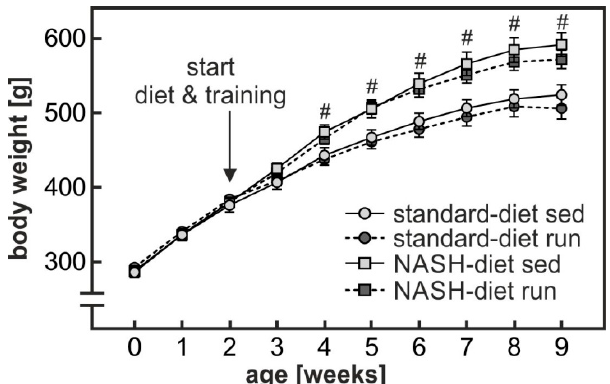
Figure 1. NASH-diet-dependent increase in body weight gain. After two weeks of adaptation (see Supplementary Figure S1) rats received either a standard chow diet (standard-diet) or a high fat, high cholesterol, high fructose NASH-inducing diet (NASH-diet) for 7 weeks. Both diet groups were subdivided into a sedentary group (sed) and a group subjected to treadmill endurance exercise (run) (see methods section (paragraph 1) and Supplementary Figure S1). Body weight was determined weekly. Values are means ± SEM. Statistics: Multiple Student’s t -test for unpaired samples; #: sedentary or exercised NASH-diet groups versus sedentary or exercised standard-diet groups, p < 0.05.